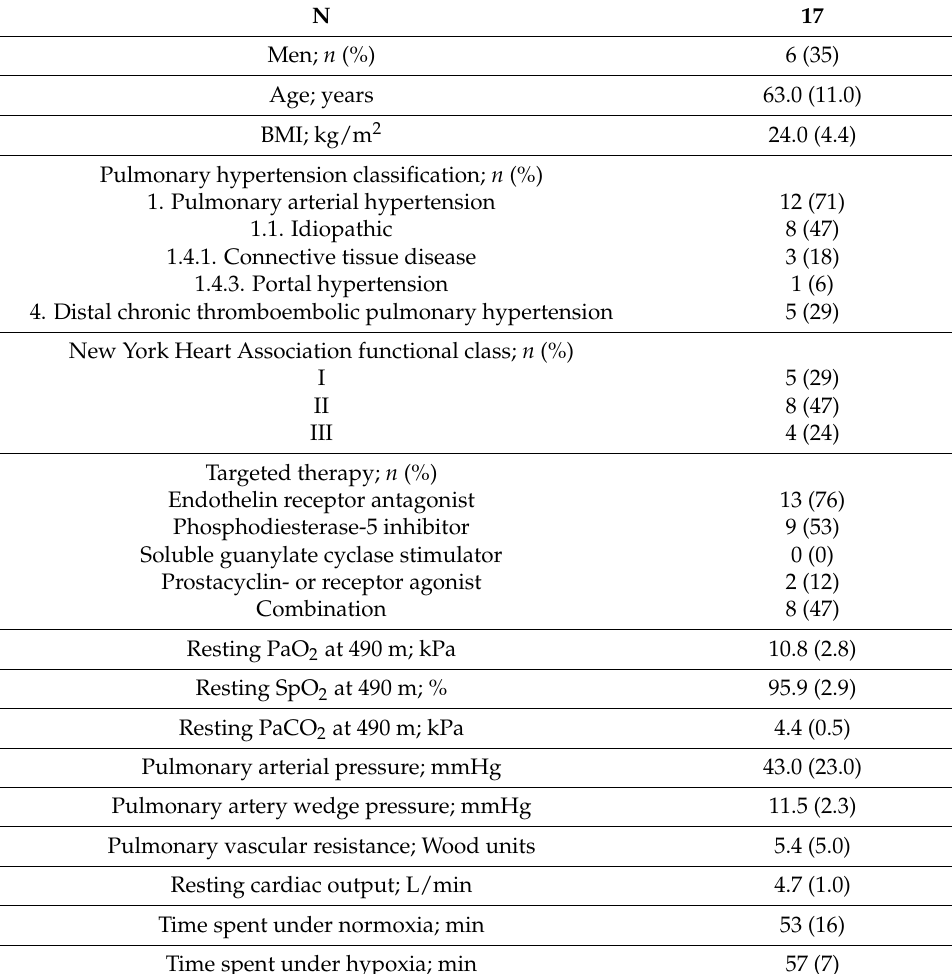
Figure 1. Patients’ flow. Table 1. Patients’ characteristics.